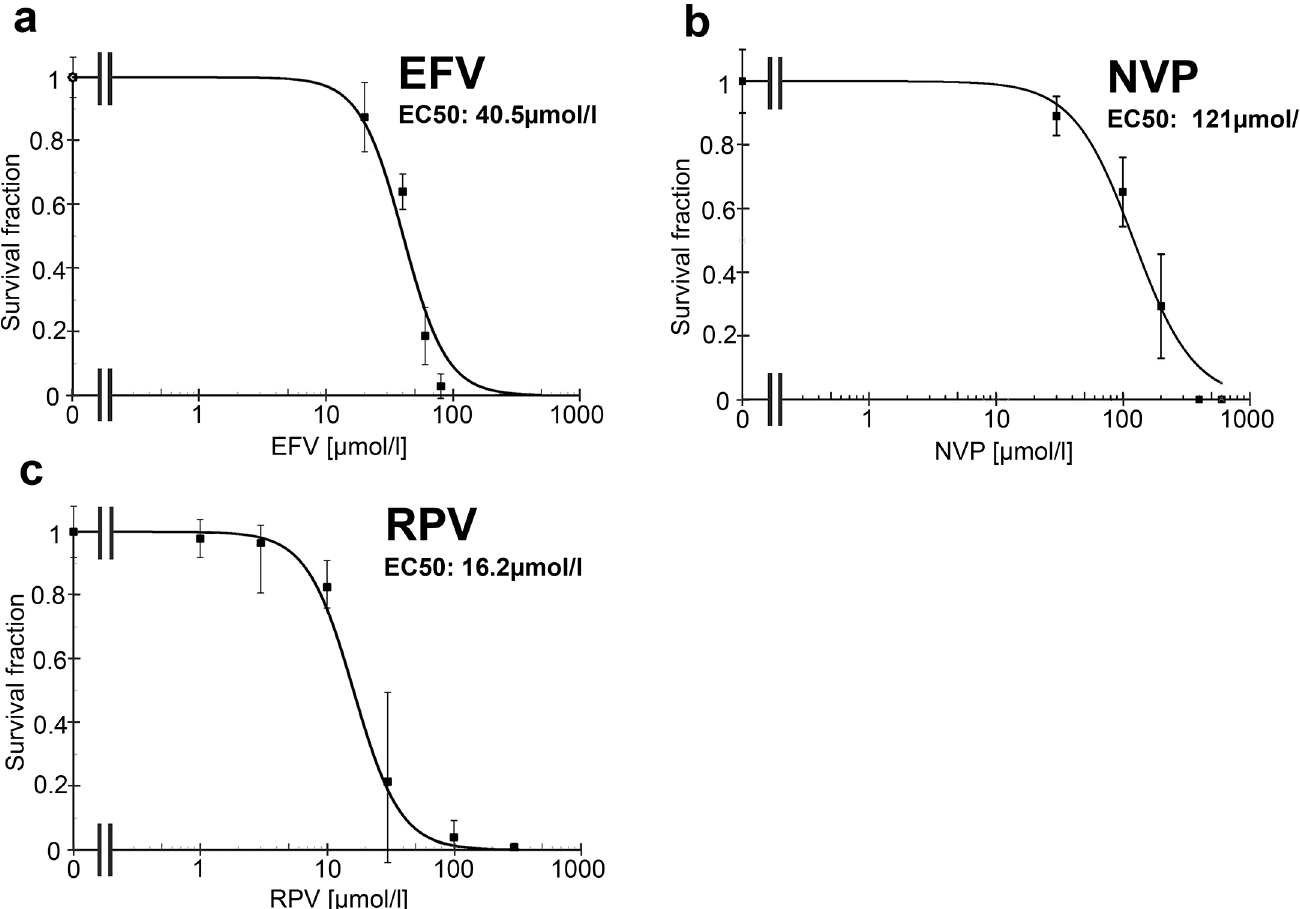
Fig 3. Effect of EFV, NVP and RPV on the survival fraction of cancer cells. Colony formation assays were performed with (a) EFV, (b) NVP and (c) RPV. The pancreatic cancer cell line BxPC-3 was treated for 72h with each of the drugs. The survival fraction (SF) was analyzed and normalized to the control. Graphs were fitted and the EC50 was calculated.